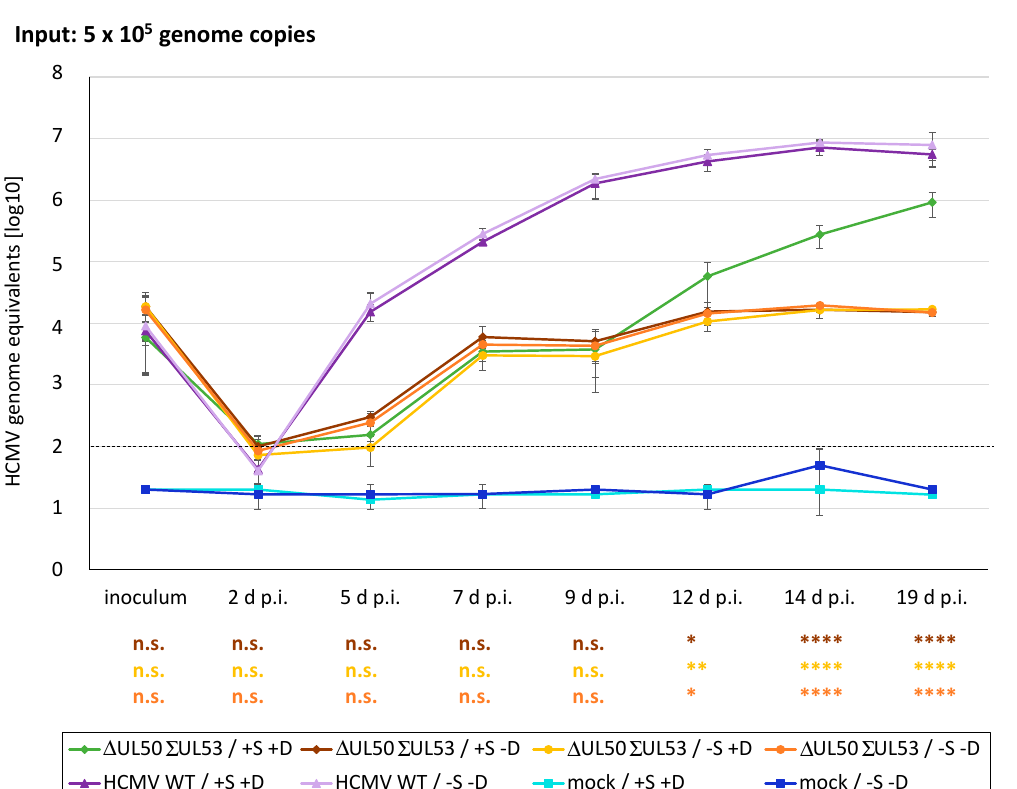
Figure 15. HCMV ∆ UL50- Σ UL53 replication kinetics in HFF-UL50 cells applying different Shield-1 and Dox conditions. HFF-UL50 cells were cultivated in 24-well plates and infected with